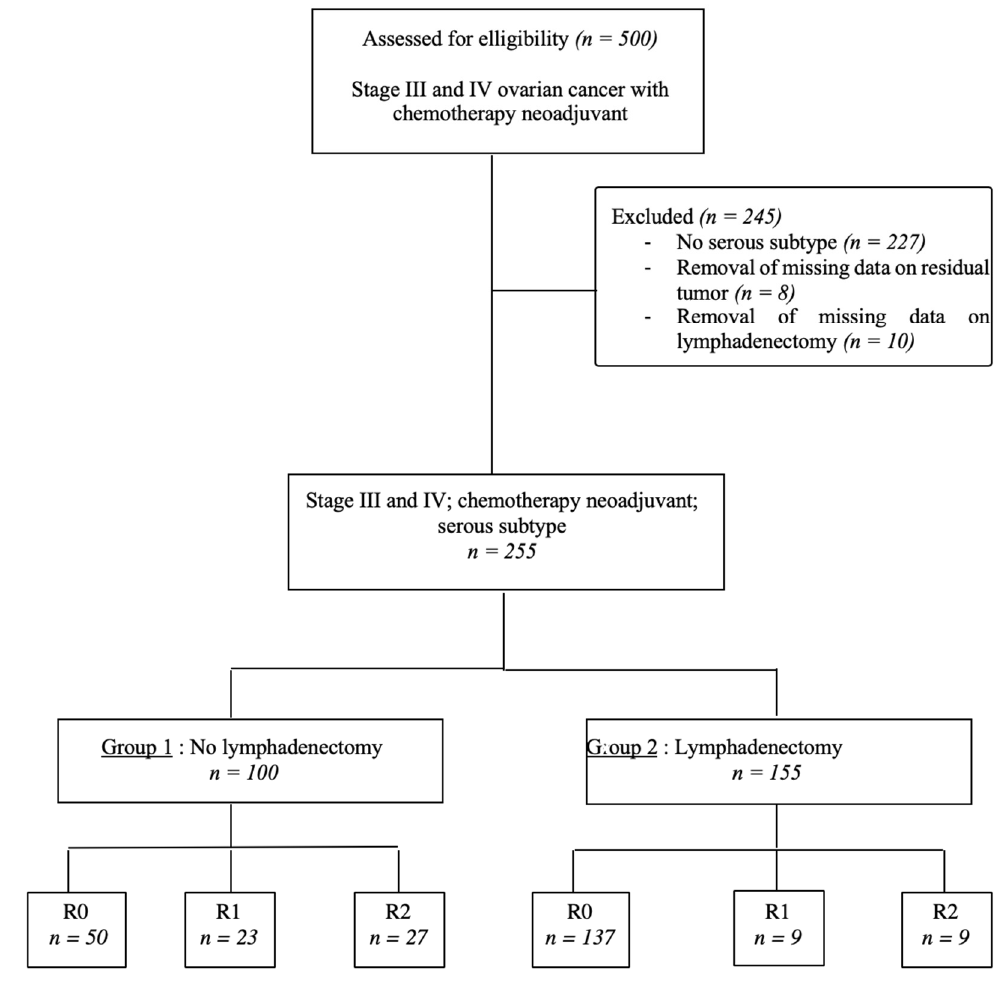
Figure 1. Flowchart of patient selection.